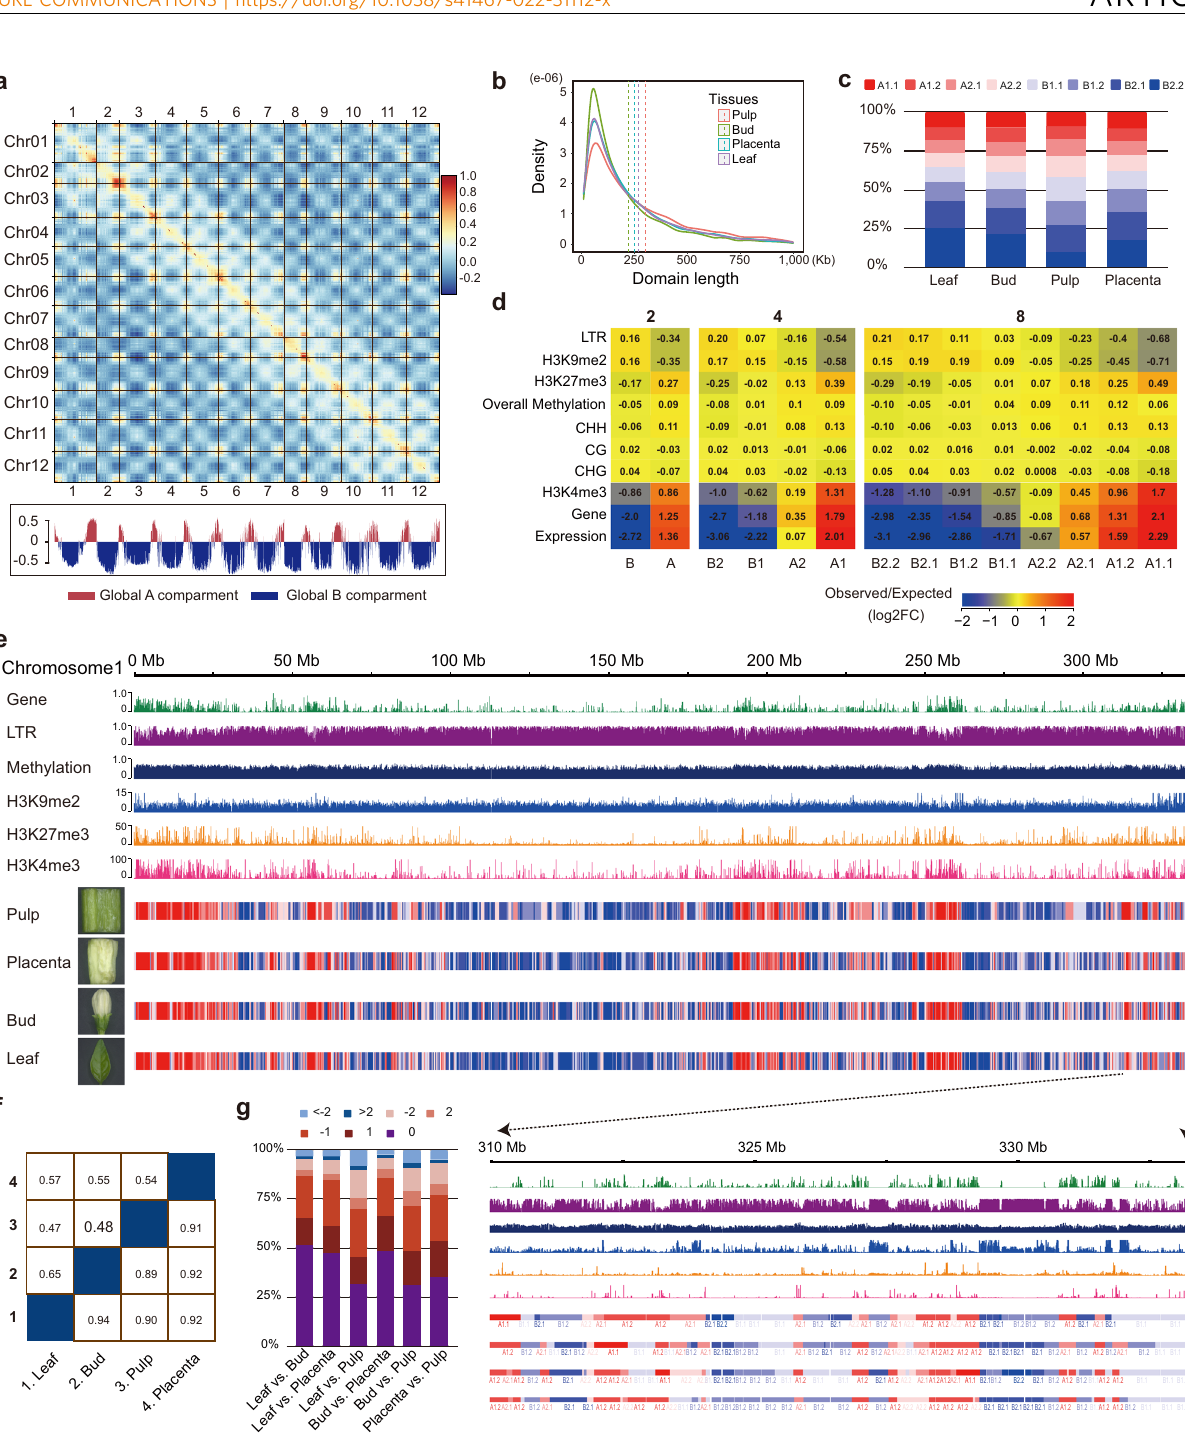
HDF domains occupy ~60% of the genome (Supplementary Fig. 14a) and have a mean length of about 1.1 Mb, which is signi fi cantly larger than either active (734 kb) or inactive domains (698 kb) (Fig. 4c). Approximately 89.2% of genomic regions in the active domains were assigned as “ A ” compartments, while 87.7% of genomic regions in the HDF domains were assigned as “ B ” compartments (Supplementary Fig. 14b), suggesting domains in the same group tend to belong to the same compartment. We found that ~36 – 45% of TAD-like domain boundaries called at 10-kb or 100- kb resolution overlapped with the boundaries of Calder -inferred subcompartments called at the same resolutions (Fig. 4d). Indeed,